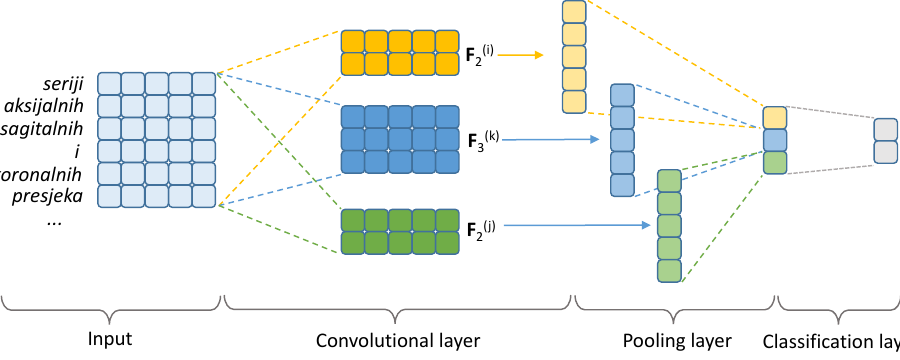
Figure 1. An illustration of the architecture of the vanilla CNN we used for text